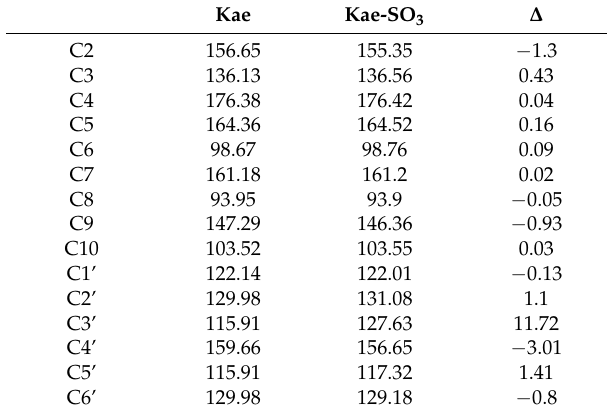
Table 1. 13 C nuclear magnetic resonance (NMR) chemical shifts (ppm) for Kae and Kae-sulfonate.